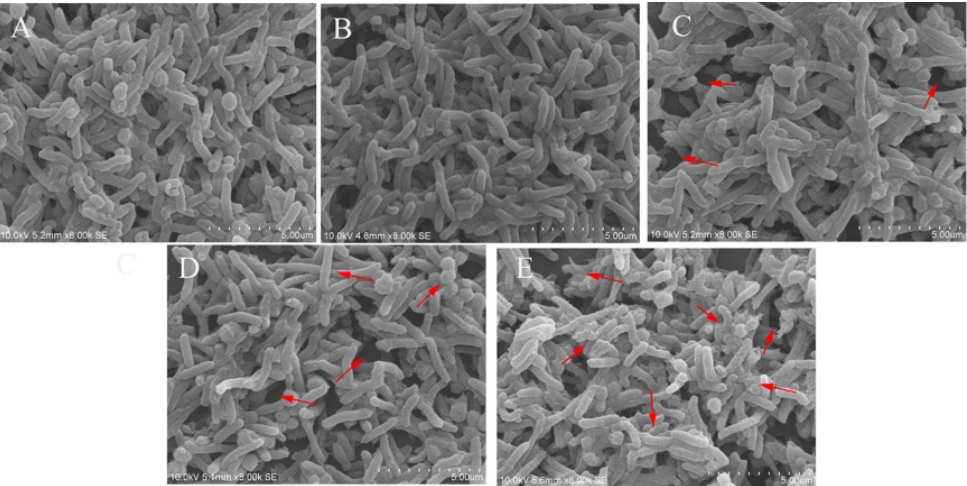
Figure 3. Effects of different treatments on a 4-day mature H. pylori 3192 biofilm under SEM. ( A ) (Control group): BB2, ( B ) (FIC group): 1 × FIC of AMX and CLR, ( C ) (CF5 group): 6.25% CFS of 10 5